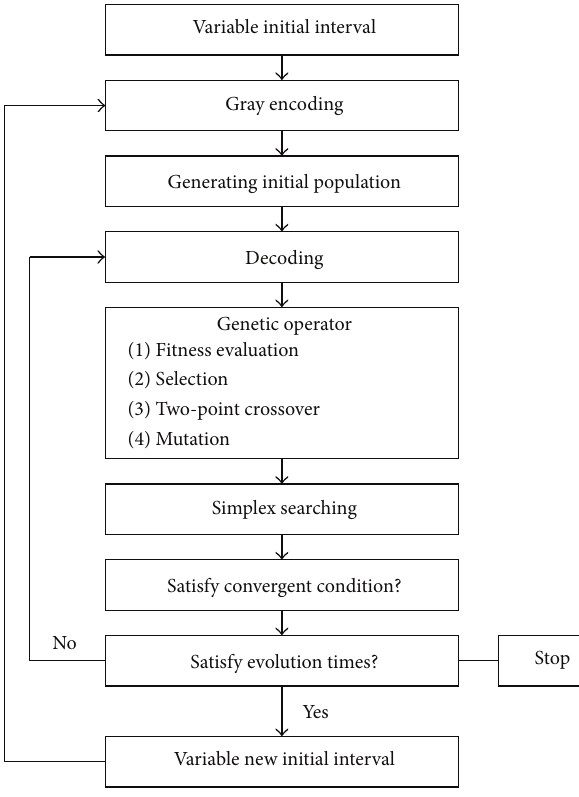
Figure 5: The flowchart for the identification of the system param- eters by